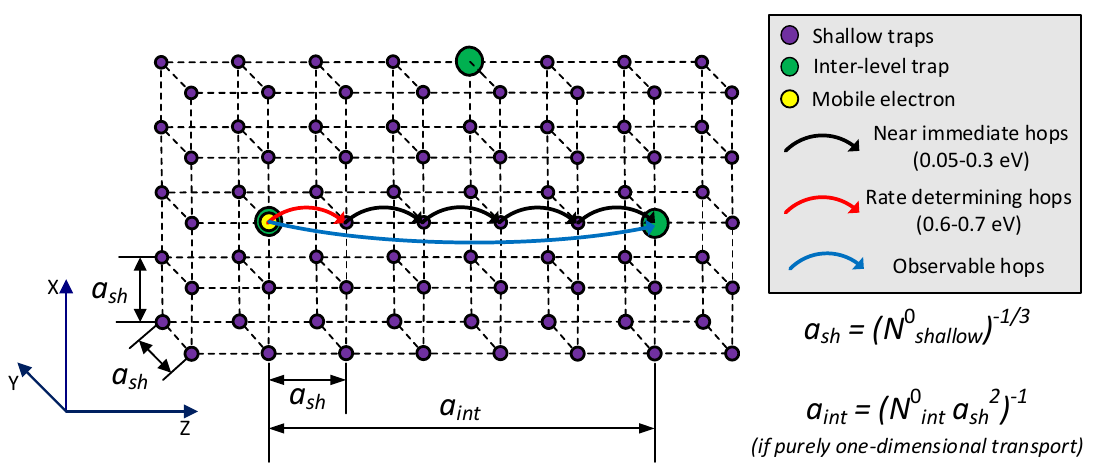
Figure 2. Schematic representation of hopping transport assuming a significantly higher shallow trap density compared to the inter-level trap density ( N 0 int << N 0 shallow ). Inter-level states can be regarded as isolated states located within a lattice of shallow states.